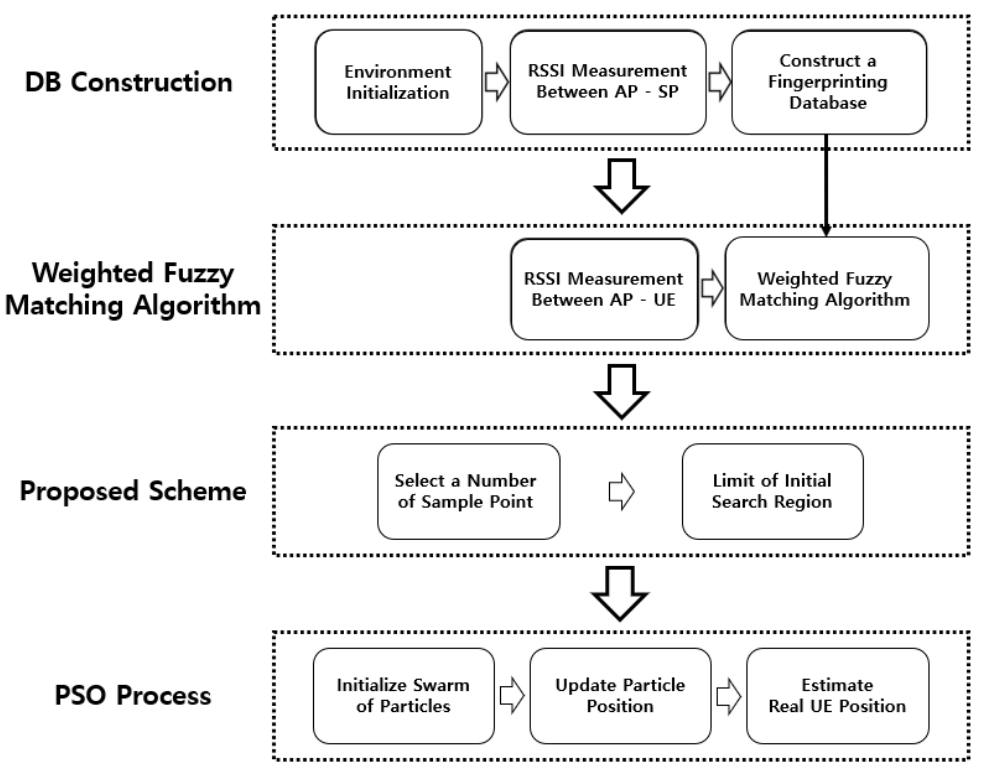
Figure 2. Proposed scheme with modified particle swarm optimization.